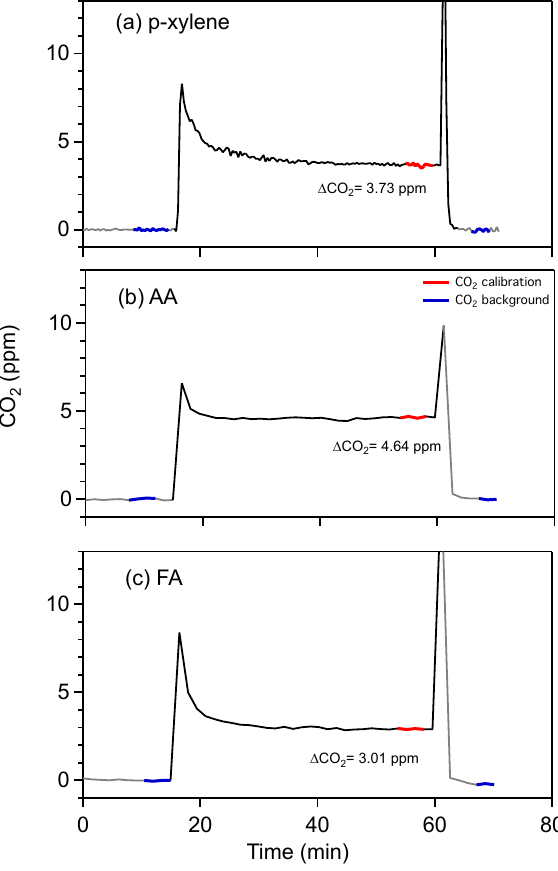
Figure 1. Example CO 2 measurements obtained during calibration of (a) p -xylene, (b) acetic acid (AA), and (c) formic acid (FA). A 15sccm carrier gas flow containing a VOC from a temperature- controlled permeation source passes through a catalytic converter, and the resulting CO 2 is then quantified using a non-dispersive in- frared detector (LICOR 840A). Bypassing the catalytic converter enables a background measurement before and after each cali- bration. In this case, calibrated mixing ratios of 9.78, 49.1, and 61.04ppb were determined for p -xylene, AA, and FA in the PTR- MS inlet system based on the corresponding CO 2 increase ( (cid:49) CO 2 ), the number of carbon atoms per molecule, and the downstream di- lution